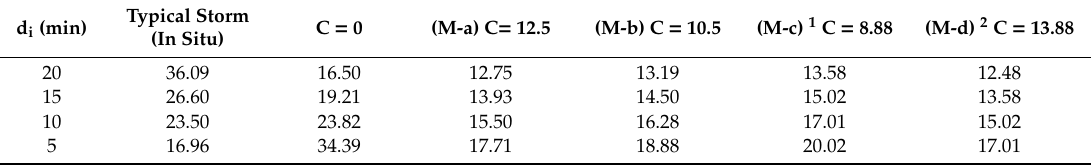
Table 4. Rainfall intensities (mm / h) for di ff erent short duration storms, estimated at station CH-03 with di ff erent proposed values of parameter C